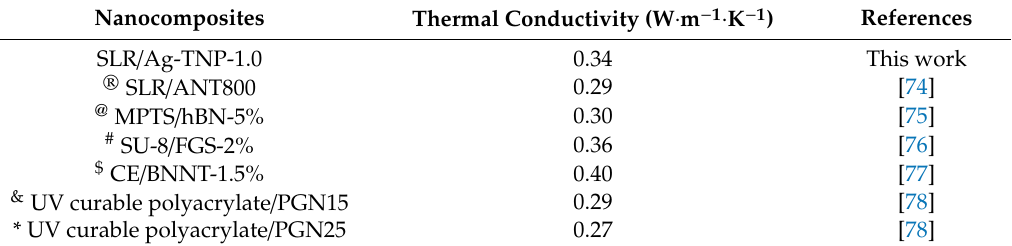
Table 6. The photocurable resin / nanofillers thermal conductivity comparison study with di ff erent